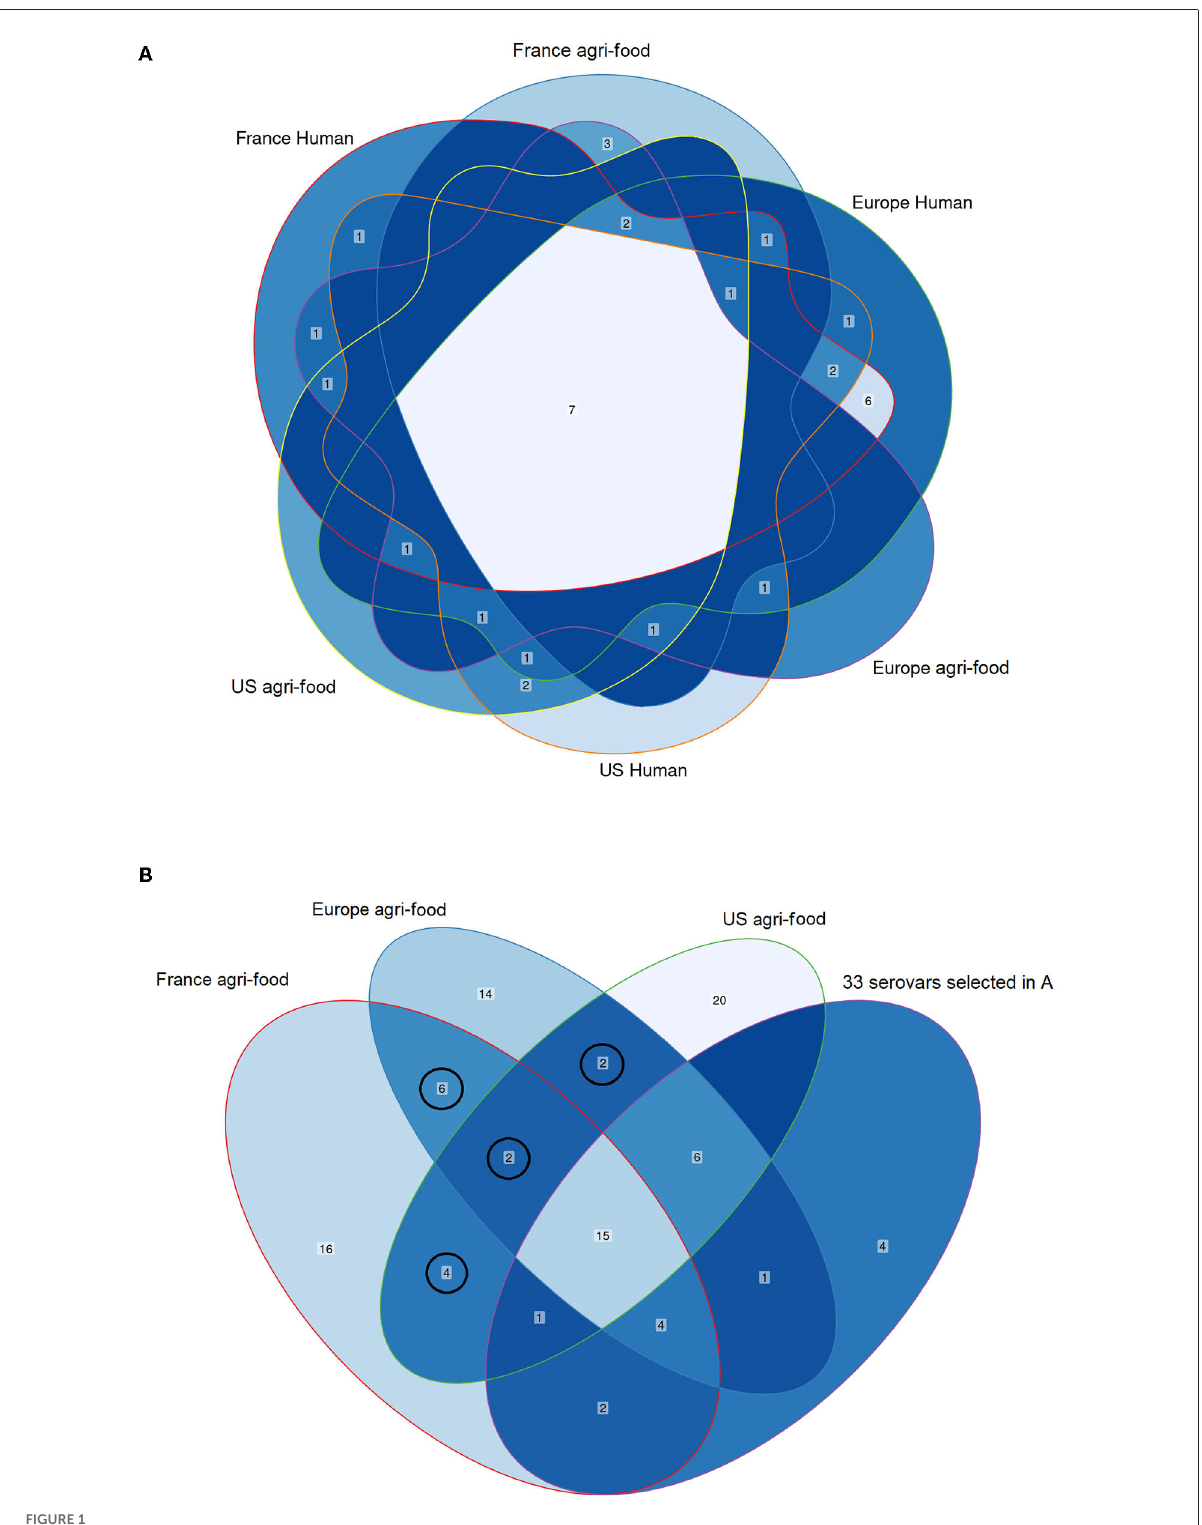
FIGURE1 Venn diagrams illustrating the intersection between the most frequently isolated serovars in the United States (US), Europe (EU) and France (FR) from human cases and from the agri-food sector. Venn analysis was carried out in two steps showed in (A,B) . (A) Intersections between the top 25 serovars in human cases and the agri-food sector. The leading 25 human US, EU and FR serovars are included in the orange-, green- and red-outlined areas, respectively. The leading 25 agri-food sector US, EU and FR serovars are included in the yellow-, purple- and blue-outlined areas, respectively. The logical relation between the top 25 serovars in human cases and agri-food sector revealed 33 common serovars. The numbers within the intersections correspond to the common serovars. (B) Intersections between the leading 50 US, EU and FR agri-food